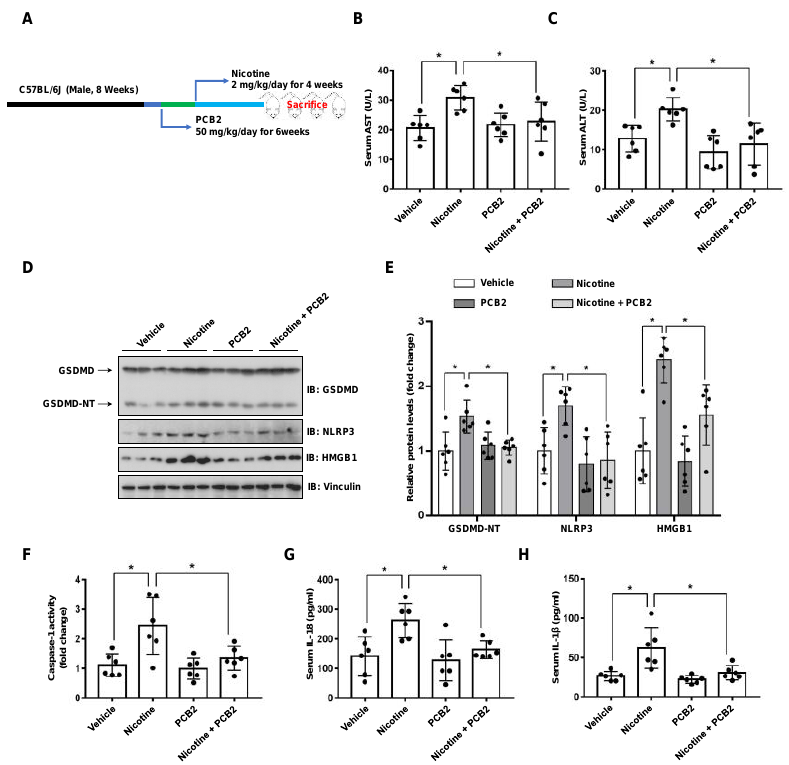
Figure 6. PCB2 ameliorates nicotine-induced pyroptosis and liver damage in mice. C57BL/6J mice were administrated with PCB2 (50 mg/kg/day) or saline for 6 weeks. After 2 weeks of PCB2 administration, mice were received daily IP injection of nicotine (2 mg/kg/day) or saline for 4 weeks. ( A ) A schematic illustration of the animal treatment procedure. ( B ) Serum levels of AST. ( C ) Serum levels of ALT. ( D ) Immunoblot analysis of the protein levels of GSDMD, NLRP3 and HMGB1 in liver tissues of the mice. ( E ) Quantification of GSDMD-NT, NLRP3 and HMGB1 levels as in ( D ). ( F ) The activity of Caspase-1 in liver tissues of the mice. ( G , H ) The concentrations of IL-1 β ( G ) and IL-18 ( H ) in the serum of the mice. n = 6 per group; Data shown represent the mean ± SD (*, p < 0.05).